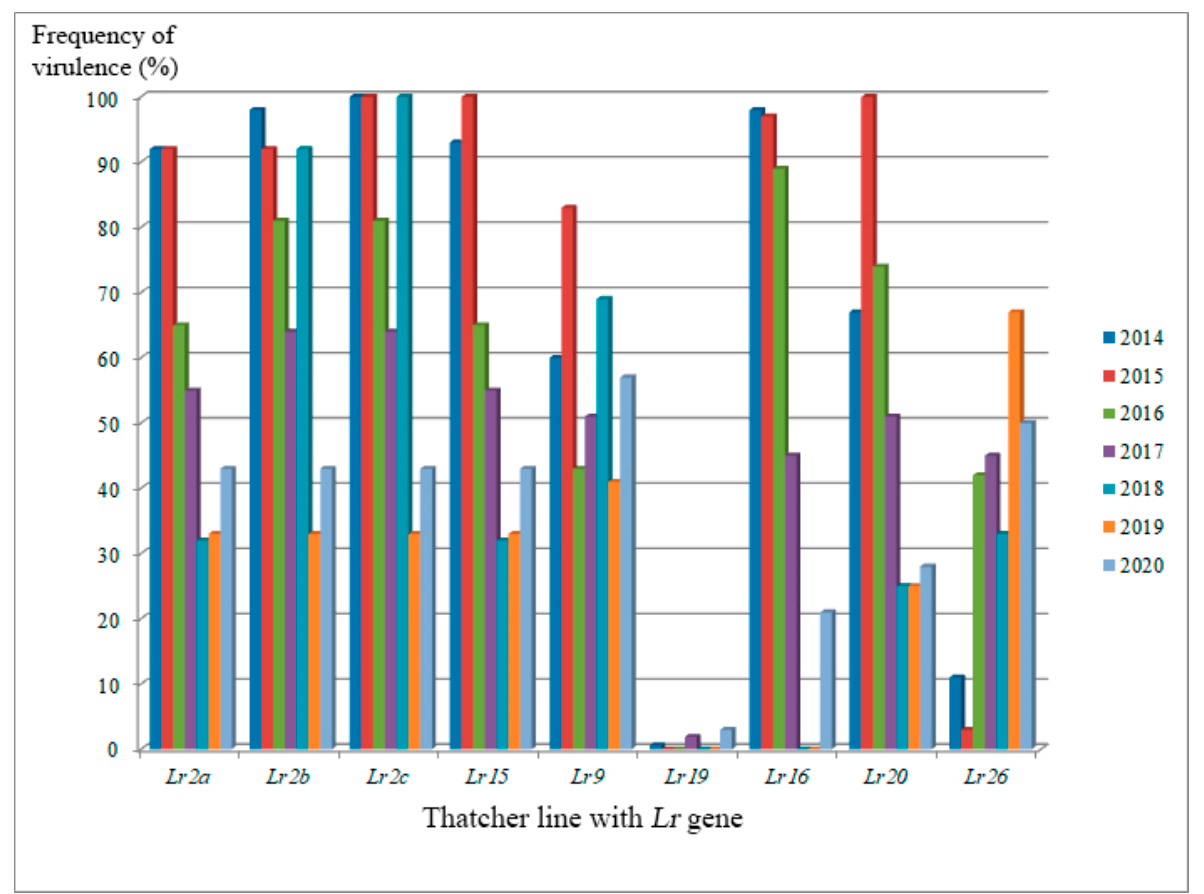
Figure 2. Virulence dynamics of the Chelyabinsk Puccinia triticina population (2014–2020). Table 3. Races of P. triticina identified on widely grown spring wheat cultivars in Chelyabinsk region in 2014–2020. Wheat